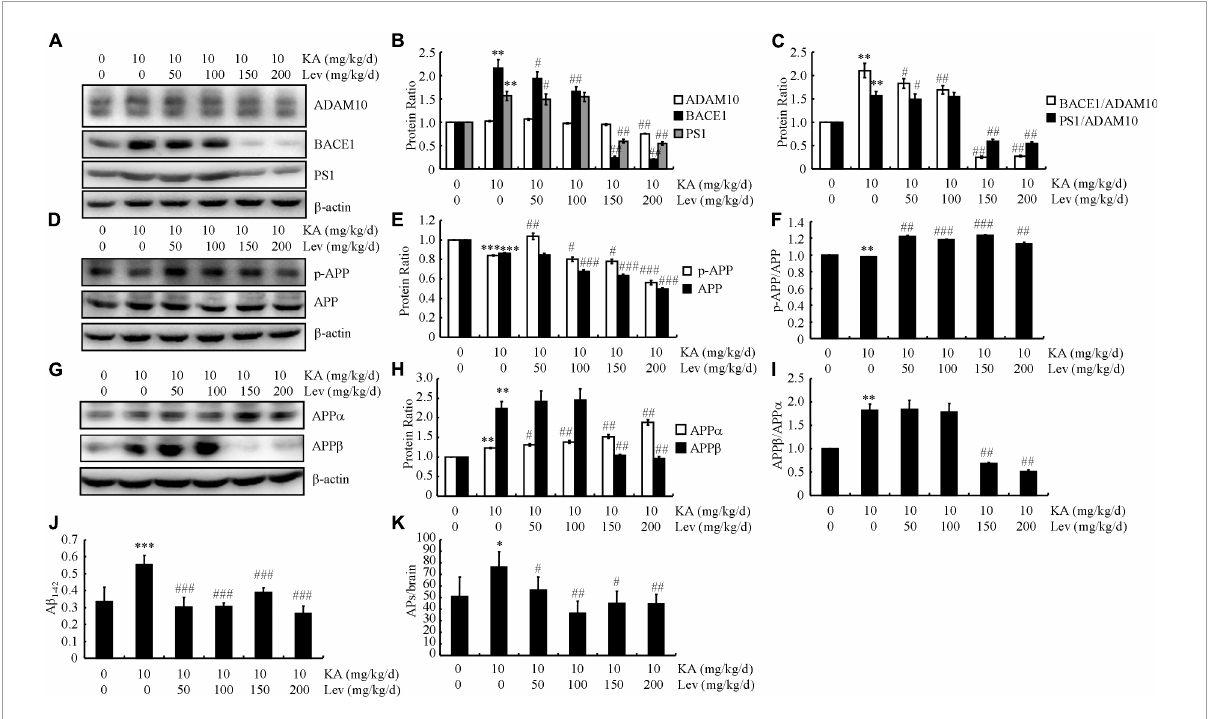
FIGURE2 High concentrations of LEV suppress the production and deposition of A β in KA-stimulated APP23/MAPT mice. (A–C) Protein levels of ADAM10, BACE1, and PS1 in the brains of KA (10 mg/kg/d)- or LEV (50, 100, 150 or 200 mg/kg) + KA-treated APP23/MAPT mice. (D–F) Protein levels of p-APP and APP in the brains of KA- or LEV (50, 100, 150, or 200 mg/kg) + KA-treated APP23/MAPT mice. (G–I) Protein levels of sAPP α and sAPP β in the brains of KA- or LEV (50, 100, 150, or 200 mg/kg) + KA-treated APP23/MAPT mice. The optical densities of bands in the western blots were evaluated using the ImageJ software. (J) The production of A β 1 − 42 , as determined using enzyme-linked immunosorbent assay. (K) The number of SPs. As determined by immunohistochemical staining (* P < 0.05, ** P < 0.01, and *** P < 0.001 vs. controls; # P < 0.05; ## P < 0.01, and ### P < 0.001 vs. the KA group; one-way ANOVA). KA, kainic acid; LEV, levetiracetam; SPs, senile plaques; A β , amyloid β